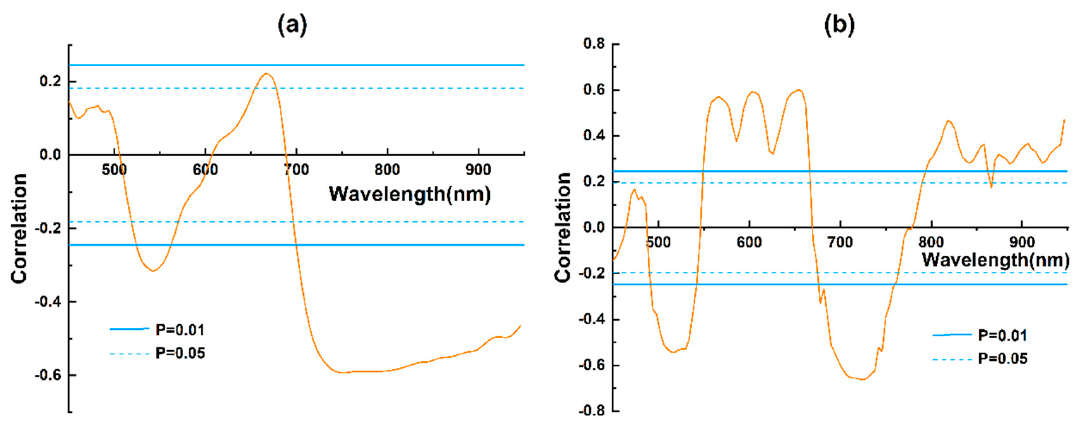
Figure S3. Correlation analysis between different damage degrees by Tomicus and the spectral parameter of Pinus yunnanensis canopy (( a ). the spectral reflectance ( b ). the first derivative of spectra).